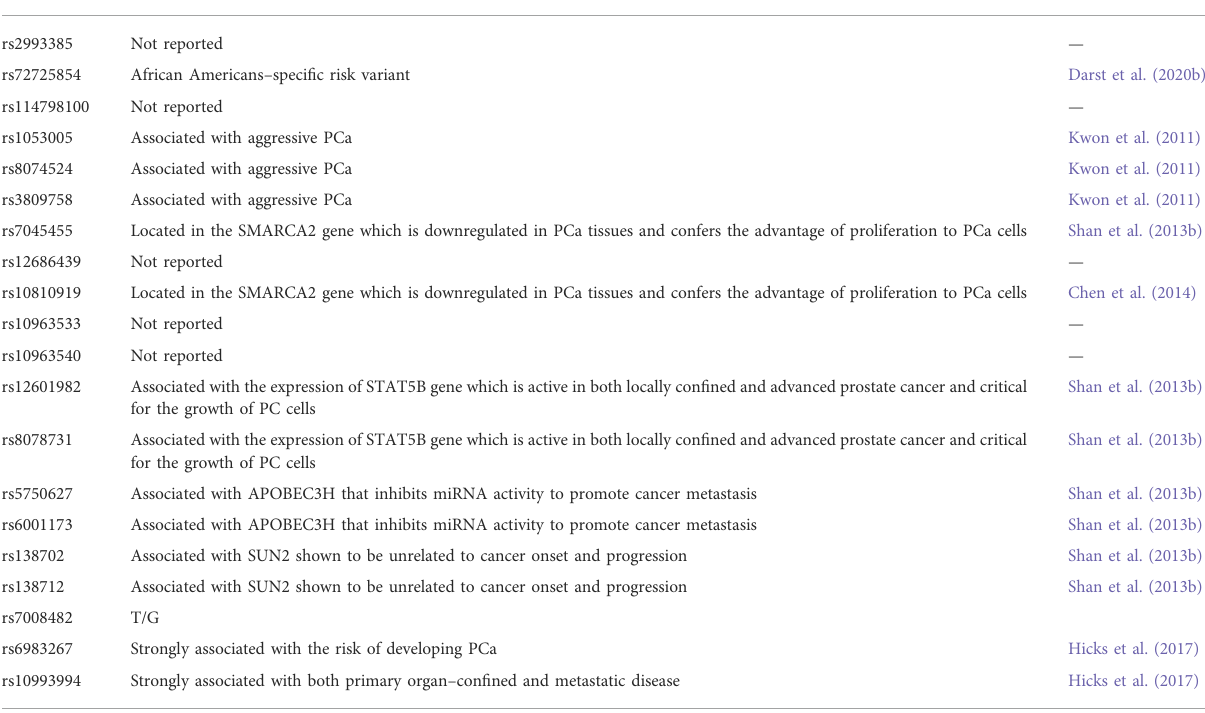
TABLE 2 Clinical signi fi cance of SNPs associated with PCa in Afro-native populations. SNP ID Clinical signi fi